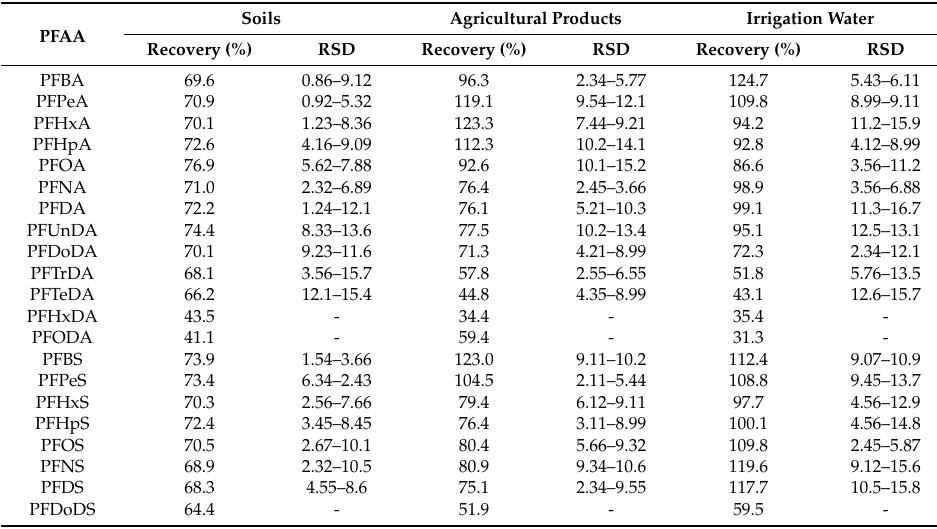
Table 1. The recaptures and RSDs (real samples) of PFAAs in soils, agricultural products and irrigation water